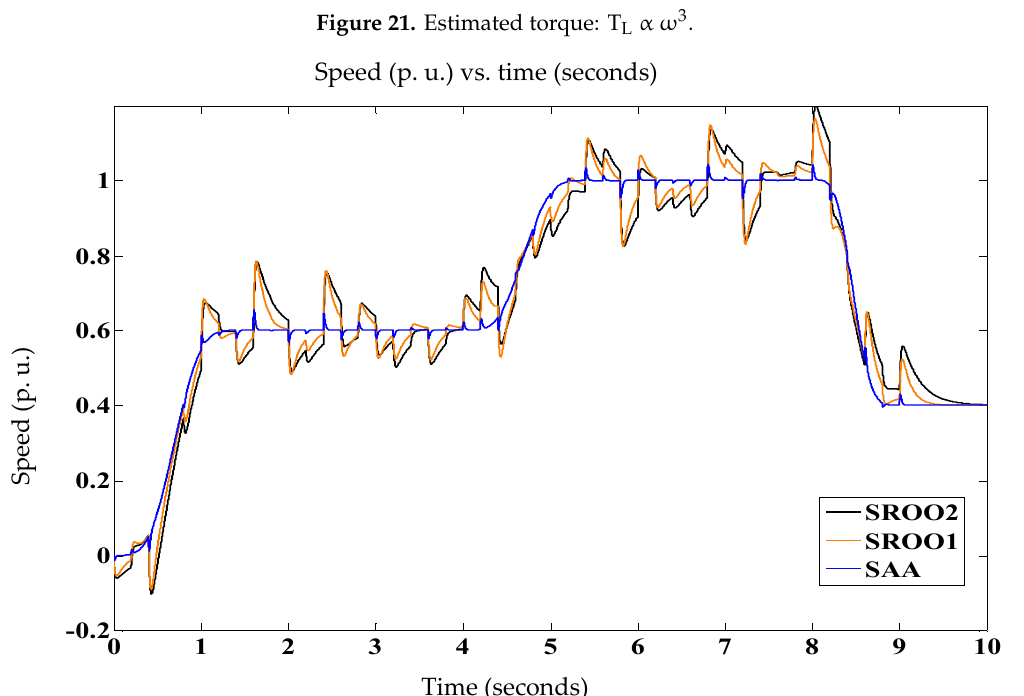
Figure 21. Estimated torque: T L α ω 3.